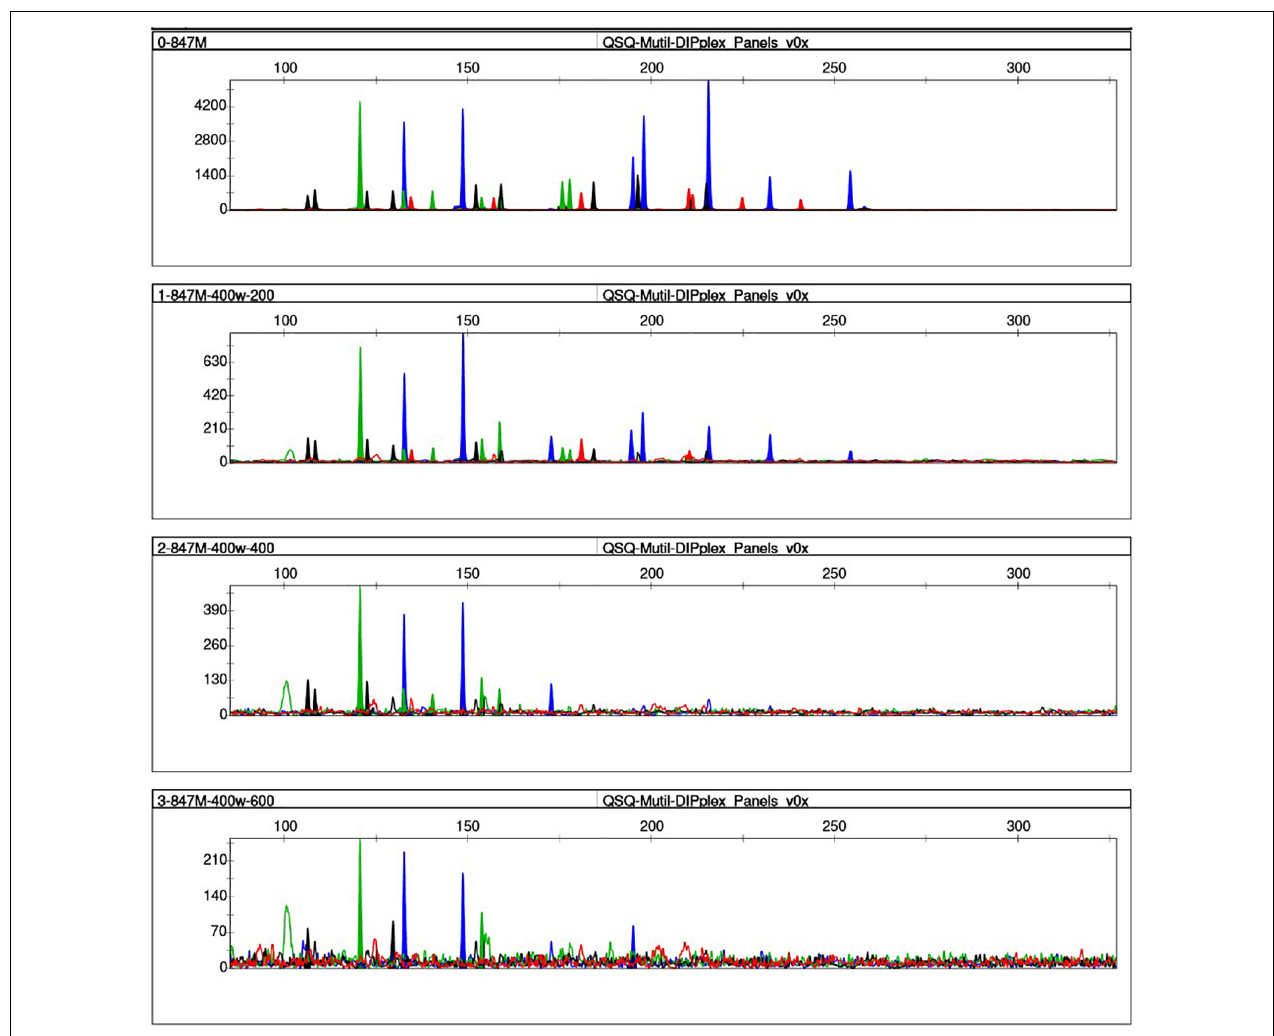
FIGURE 5 | Effects of ultrasound on DNA extracted from fresh EDTA blood. We degraded DNA using 0 (top) , 100, 200, 300, and 400 (bottom) ultrasonic cycles of 200 W for 10 s per cycle, with 4 s between